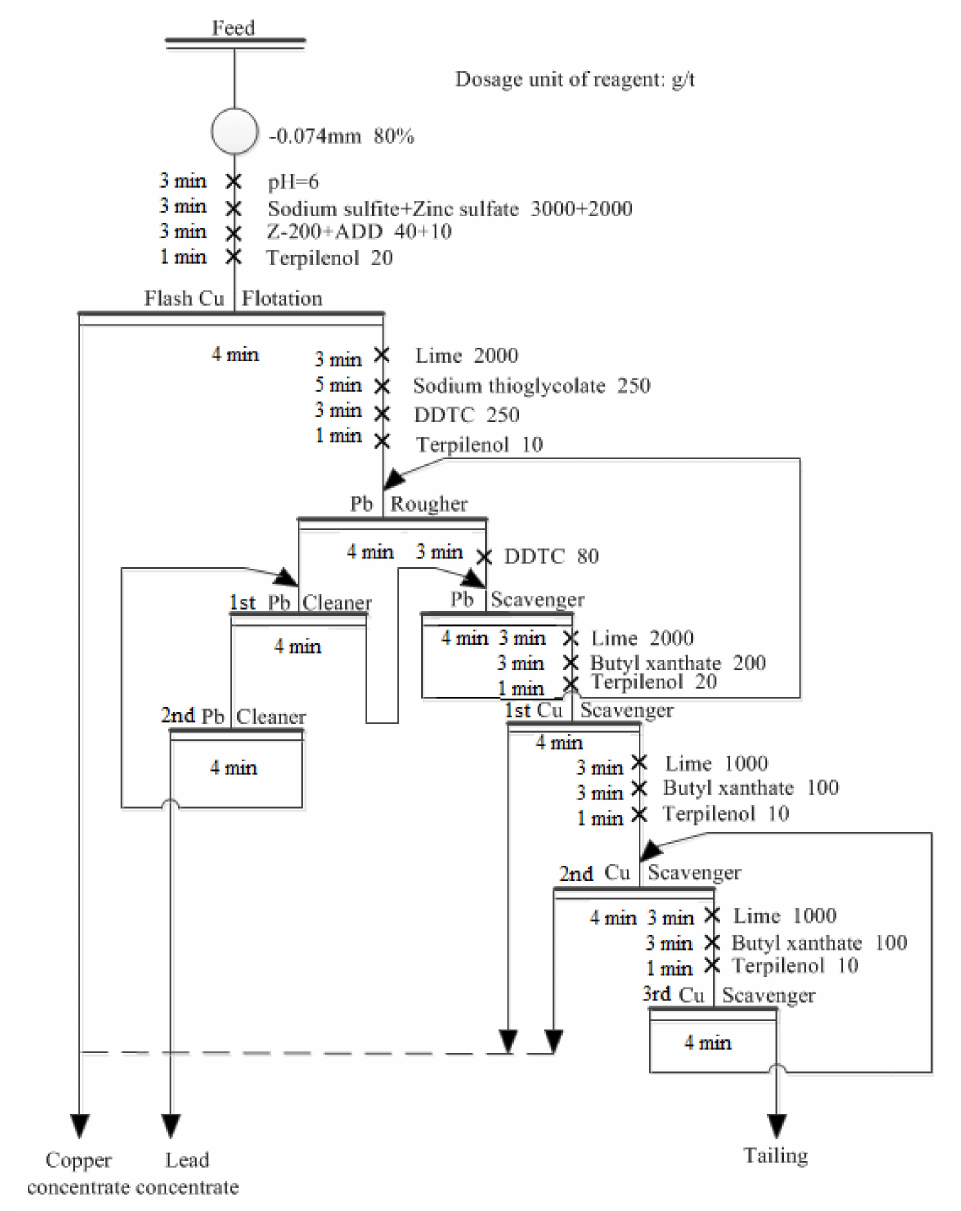
Figure 9. Closed − circuit process flow chart of flotation (X stands for